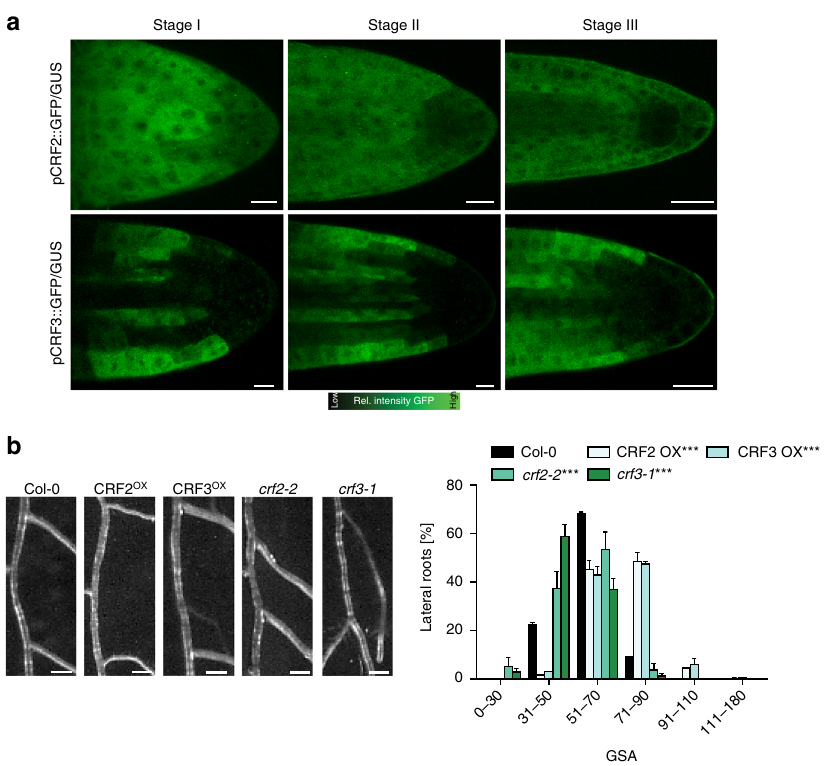
Fig. 3 Characterization of cytokinin response factors (CRFs) in lateral roots. a Representative images of pCRF2::GFP/GUS and pCRF3::GFP/GUS in stage I – III LRs. Scale bar, 25 µ m. b Representative images and GSA distribution of Col-0 wild type, crf mutants, and CRF OX lines. Kolmogorov – Smirnov test P - values: *** P < 0.001 (compared to DMSO or Col-0 ). Mean ± SEM, n = 5 plates (16 seedlings with 50 – 120 LRs per plate). Scale bars, 2 mm. a , b Experiments were repeated at least three